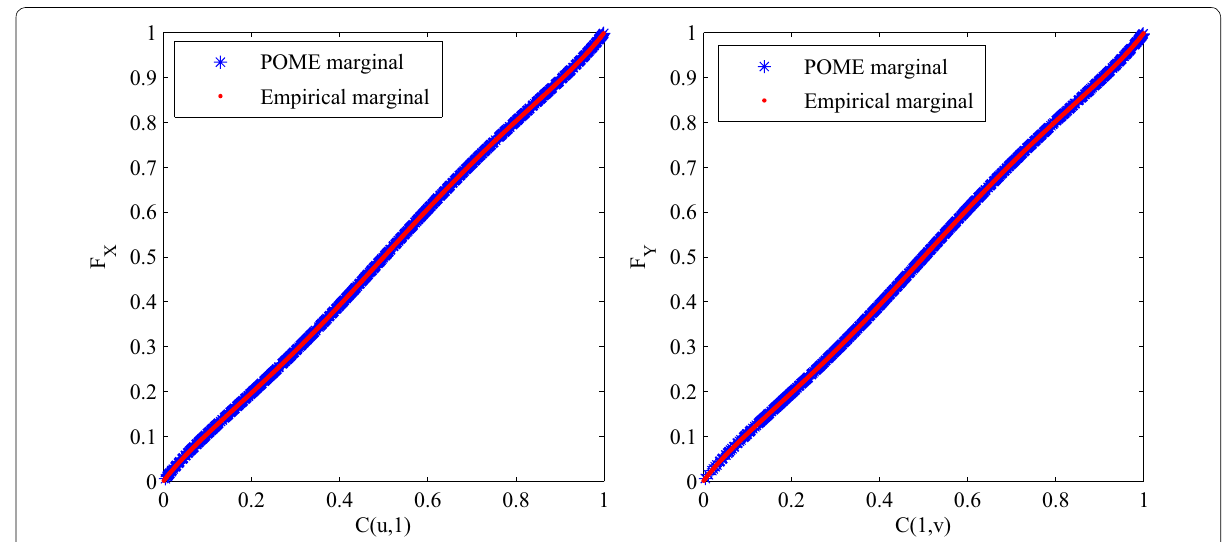
Fig. 2 Comparison of empirical and POME-univariate marginals to computed C ( u ,1 ) and C (1, v ) computed from